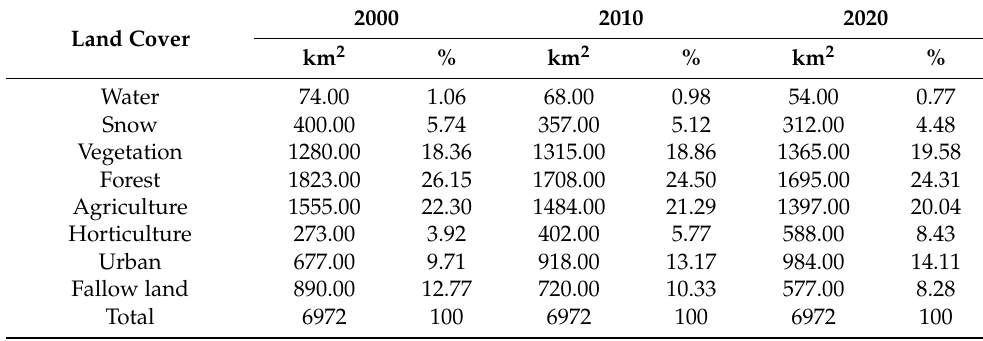
Table 2. Area proportion of LC types in 2000, 2010, and